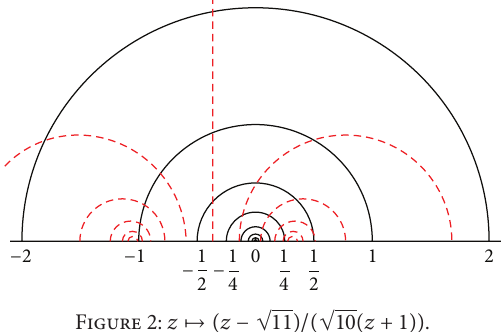
Figure 2: 𝑧 󳨃→ (𝑧 − √11)/(√10(𝑧 + 1))